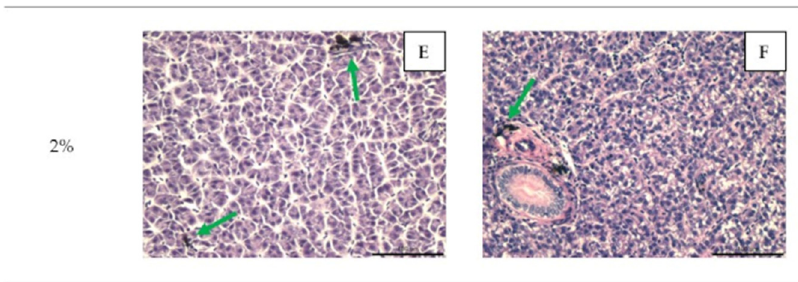
Figure 2. Histology using hematoxylin-eosin staining, evaluating the morphology of liver specimens belonging to the control groups ( A , B ), 0.5% groups ( C , D ) and 2% groups ( E , F ). Green arrows indicate the melano-macrophages. Magnification: 20 × .